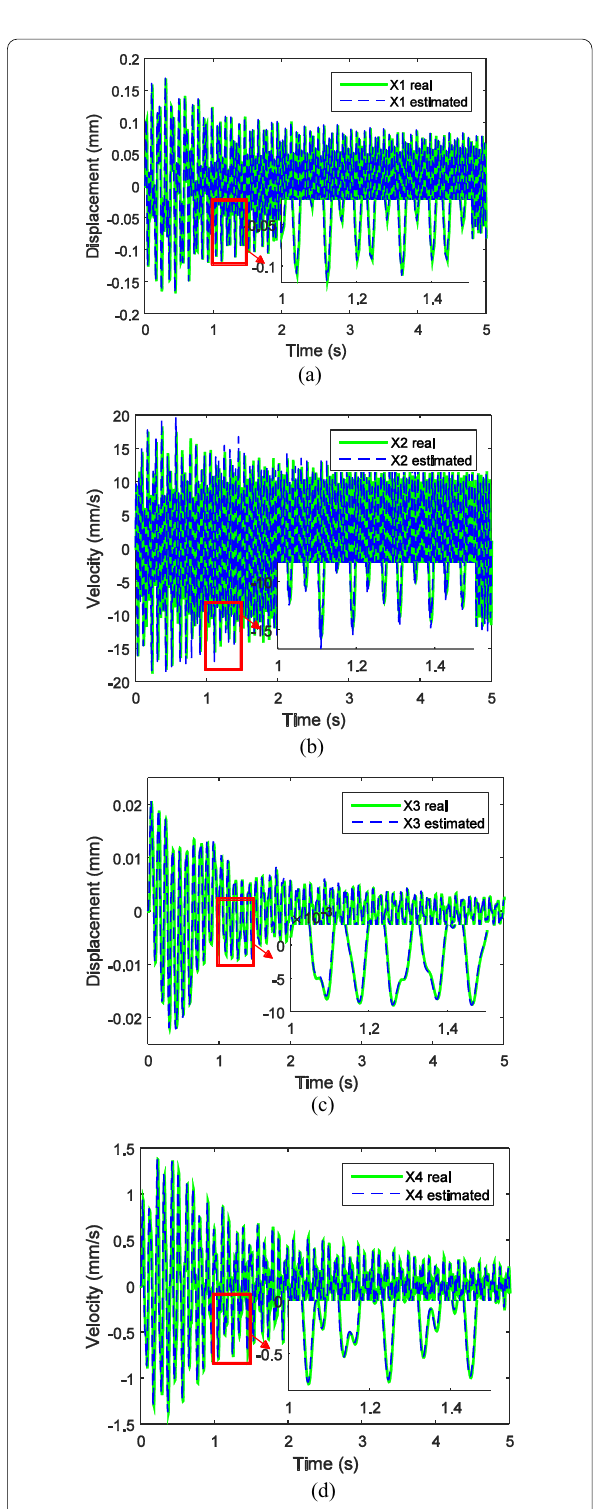
Figure 9 Comparison between estimated system state and real system state at the engine speed of 750 r/min: a X 1 : engine displacement, b X 2 : engine velocity, c X 3 : sprung mass displacement, and d X 4 : sprung mass